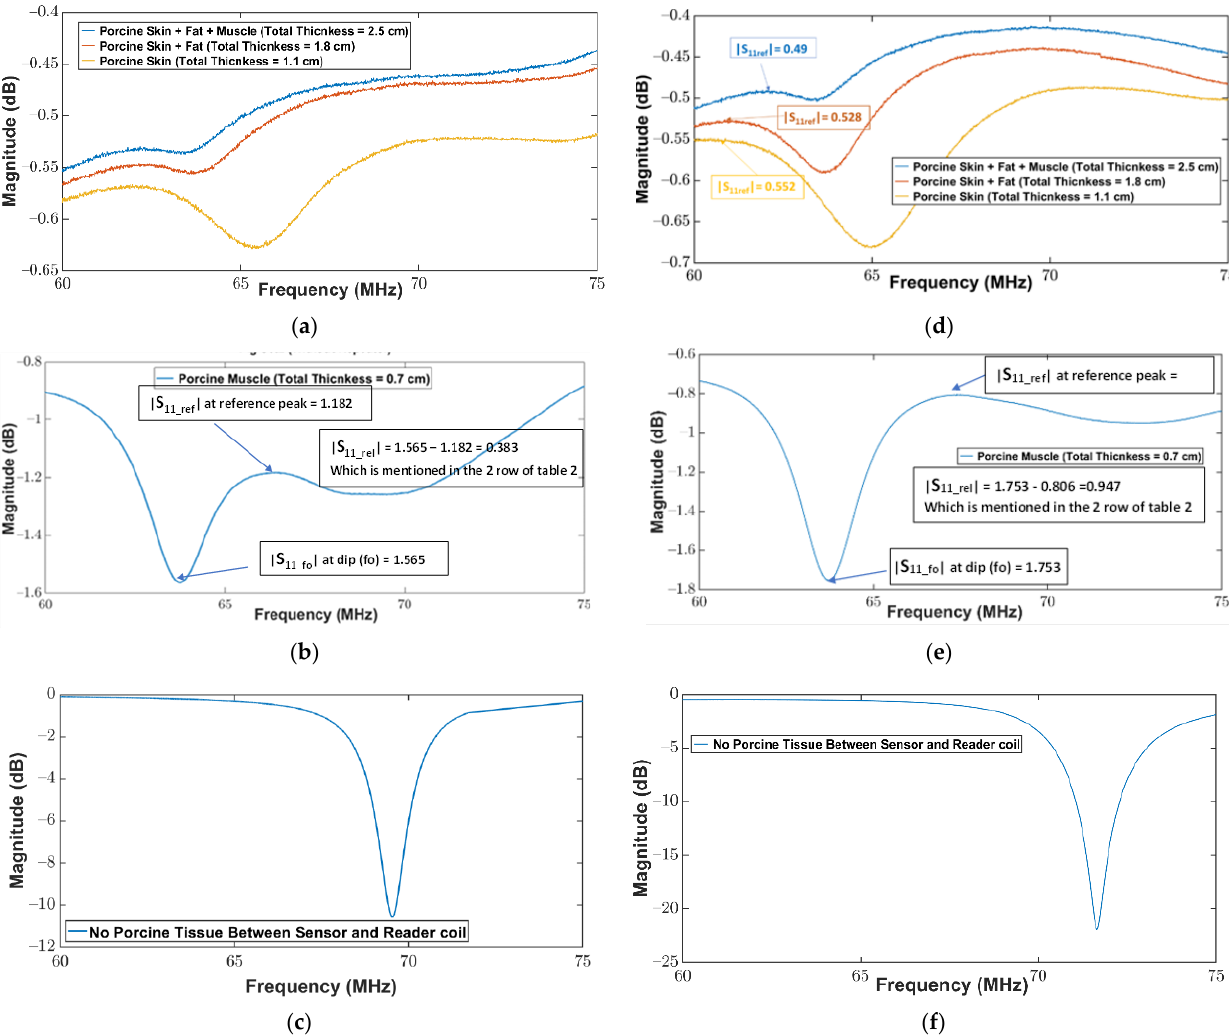
Figure 7. Magnitude of return loss ( 𝑆 11 ) as a function of frequency between the sensor and the readout coil for different thicknesses of the porcine tissue layers: ( a – c ) without repeater coil; ( d – f ) with repeater coil.